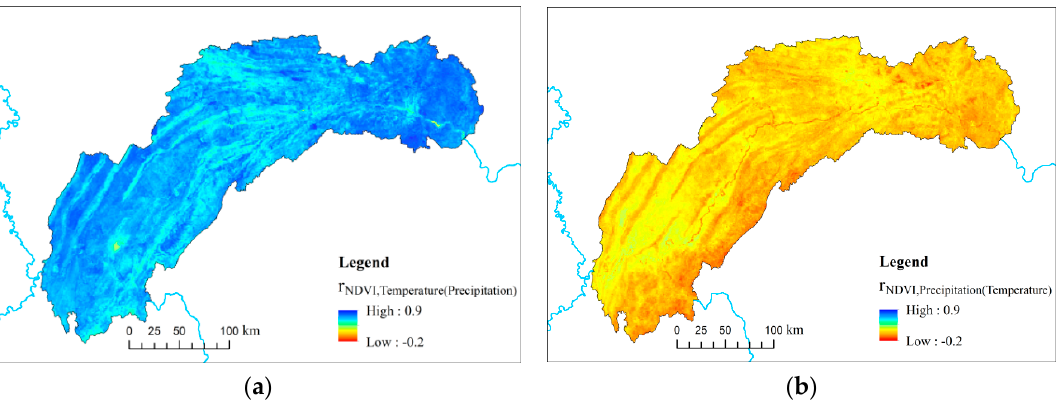
Figure 6. Spatial distribution of partial correlation coefficient: ( a ) partial correlation between NDVI and temperature, with precipitation as a control variable; ( b ) partial correlation between NDVI and precipitation, with temperature as a control variable.